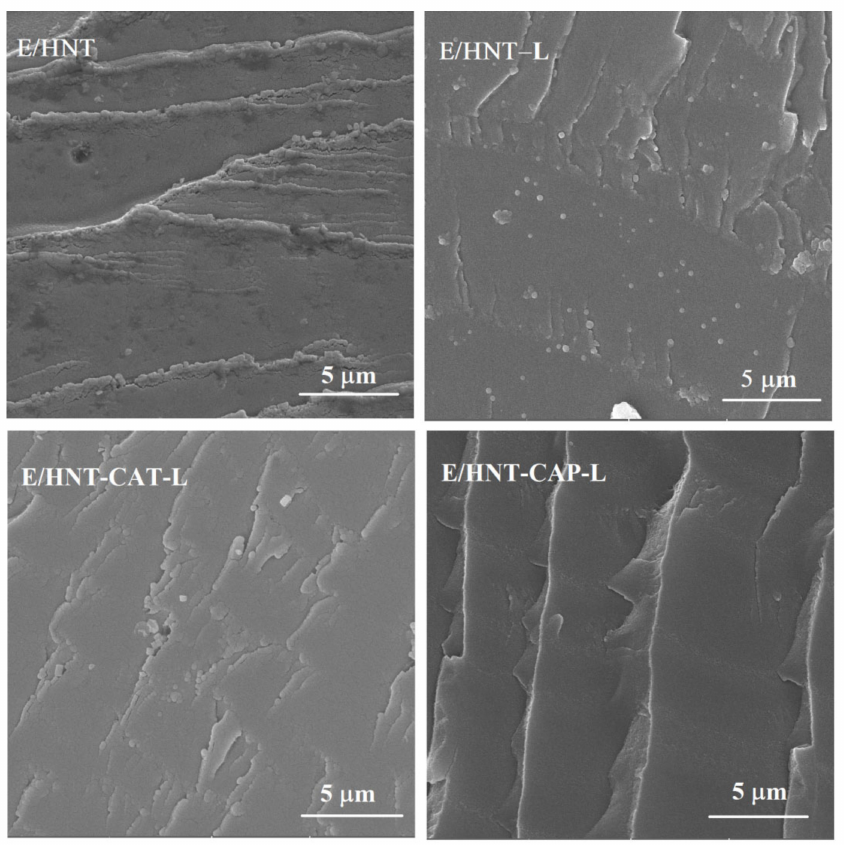
Figure 7. SEM micrographs of E/HNT, E/HNT-L, E/HNT-CAT-L, and E/HNT-CAP-L